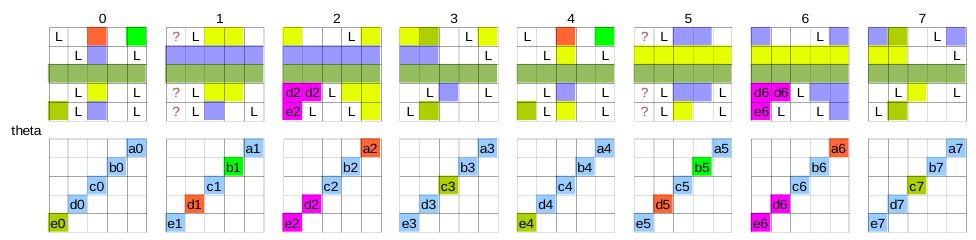
Figure 11: Scheme on exploited quadratic relations between the last output and the unknown bits for the final